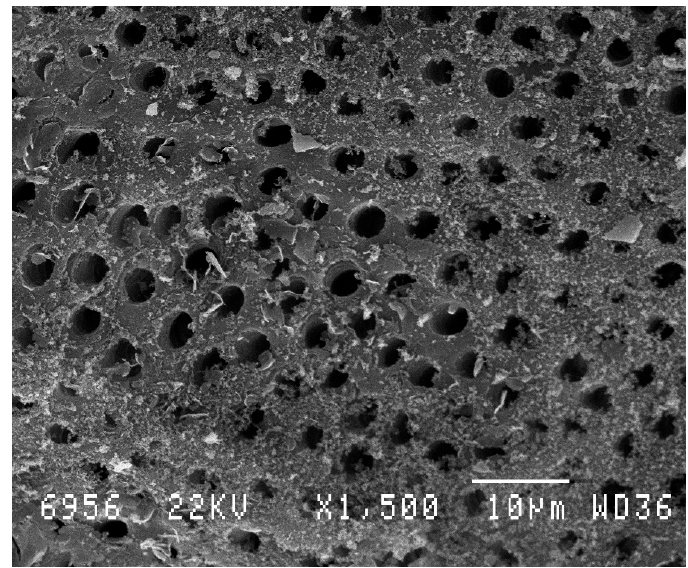
Figure 3. Scanning electron microscopic (SEM) view of unlased dentin (control) treated only with ethylenediaminetetraacetic acid (EDTA) (18%). The dentin is not covered by the smear layer. The tubules are open. Magnification: 1500×.